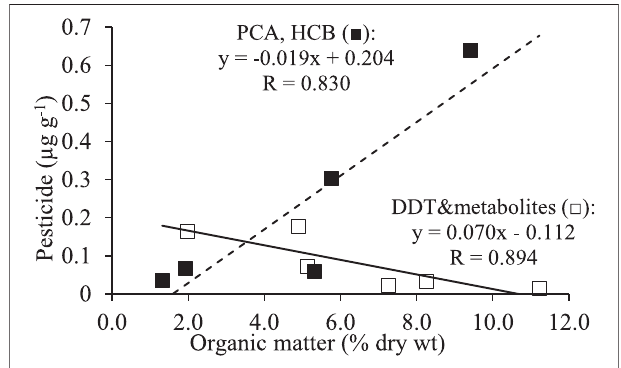
FIGURE 4 | Organic matter correlations with pentachloroaniline (PCA) and hexachlorobenzene (HCB) concentrations ( ■ ); and with dichlorodiphenyltrichloroethane (DDT) and DDT metabolites concentrations ( □ ) in old market garden soils, where gardening continued for 12 – 50 years until it ended in 1978 – 91 (n (cid:2) 3).